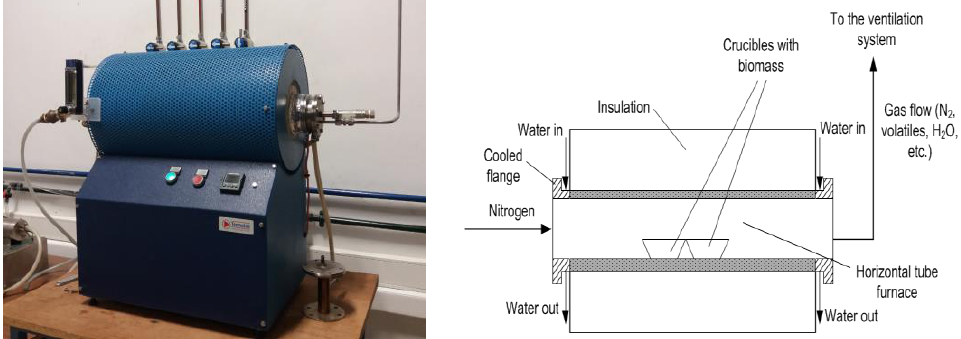
Figure 1. Experimental apparatus and scheme of the HTF.